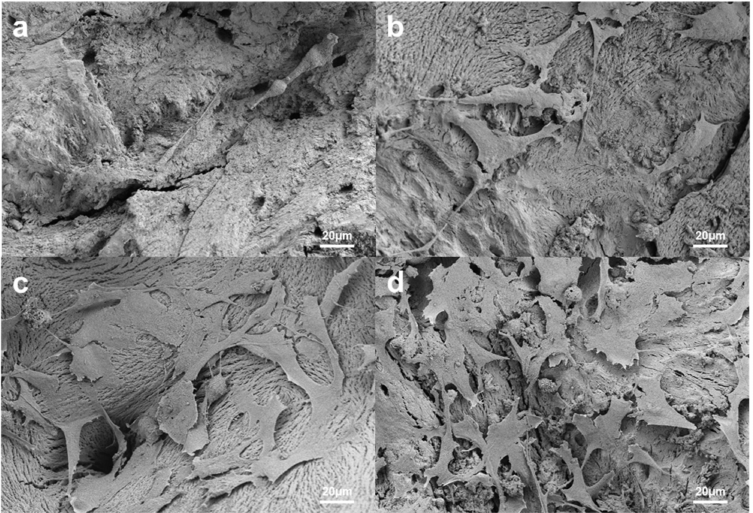
Figure 7. SEM photographs of xenograft surfaces after culture with MC3T3-E1 for 7 and 14 days. ( a ) Bo-Hy, 7 days, ( b ) Po-Hy, 7 days, ( c ) Bo-Hy, 14 days, and ( d ) Po-Hy, 14 days (original magnification × 500).